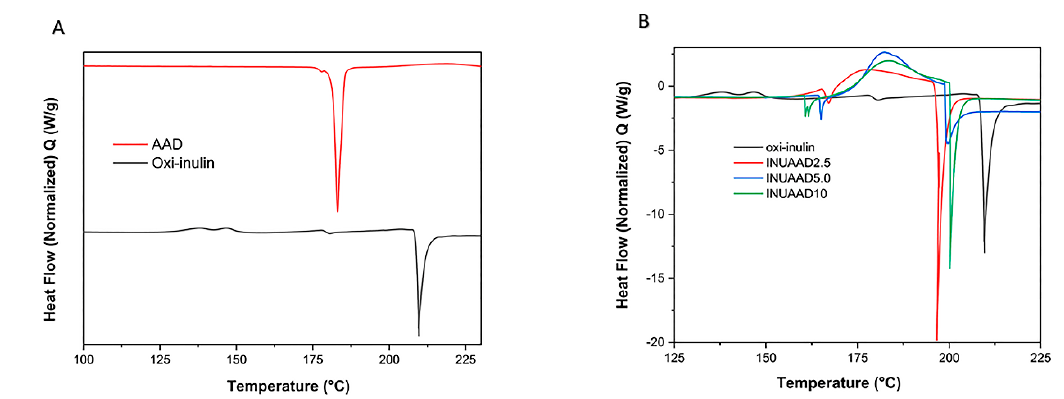
Figure 5. ( A ) Differential scanning calorimetry (DSC) thermograms of the oxidized inulin and AAD; ( B ) thermograms of the oxidized inulin and hydrogels.